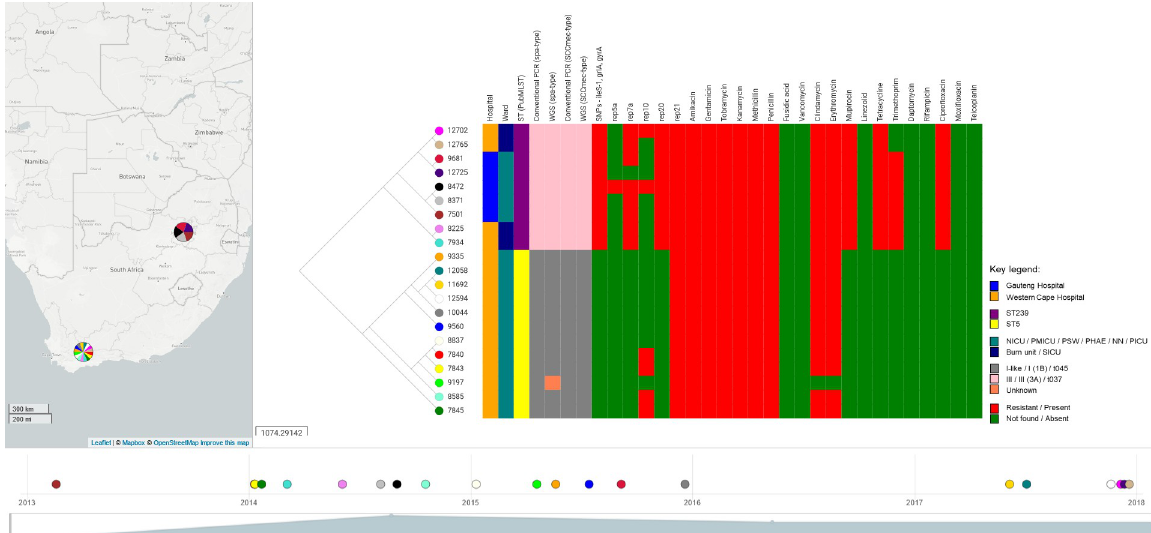
Fig 3. Molecular and phylogenetic comparison of a selected set of MRSA strains (n = 21). The phylogenetic tree and timeline was drawn with Microreact version 92.0.0 (https://microreact.org/project/sbBQtaWKnKdCHZ6L7bbQgJ/a639f664). NICU = Neonatal ICU; PMICU = Paediatric medical ICU; PSW = Paediatric surgery ward; PHAE = Paediatrics haematology; NN = Neonatology; PICU = Paediatric ICU; SICU = Surgical ICU. Reprinted from https://microreact.org/project/sbBQtaWKnKdCHZ6L7bbQgJ/a639f664 under a CC BY licence, with permission from the Centre for Genomic Pathogen